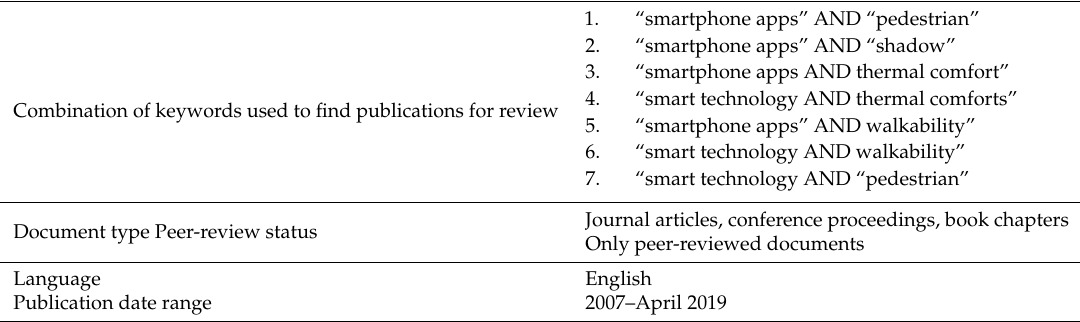
Table 2. Criteria used to select publications for review in this